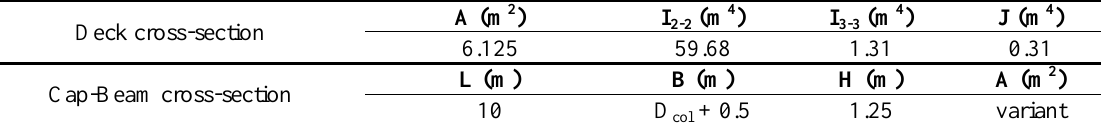
Table 3. The specifications of the deck and the cap-beam cross sections (Jahanfekr, 2011). Deck cross-section